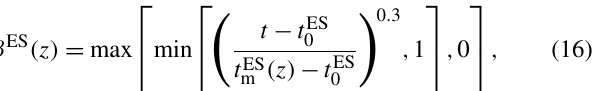
a i ln (p) i used for parameters of the EPP-NO y model for ES events. Values in i = 0